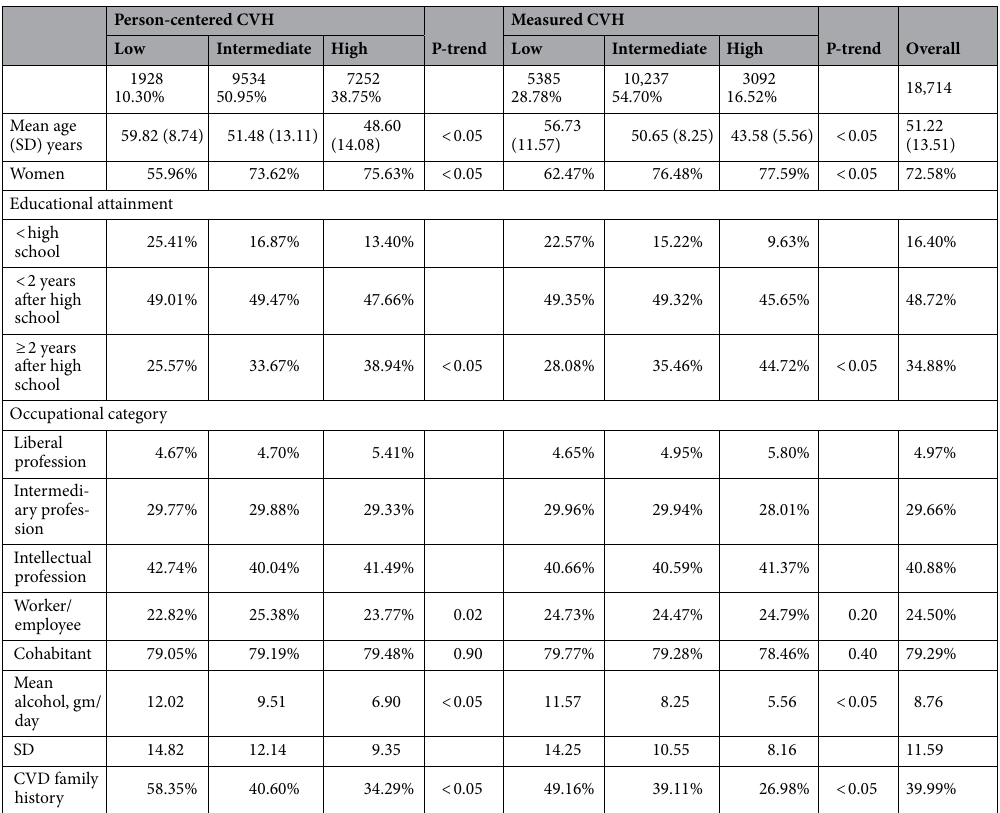
Table 2. Sample characteristics according to person-centered and measured CVH level. Values are percentages for categorical variables and mean (standard deviation) for numerical ones. Low, intermediate, and high CVH correspond to 0–2, 3–4, and 5–7 ideal LS7 metrics, respectively. Trend tests include Jonckheere trend test for numerical variables and the Chi-square trend test for categorical variables. Educational attainment categories were (1) low (less than high school), (2) intermediate (less than 2 years after high school), and (3) high (more than or equal to 2 years after high school). Occupational categories were (1) liberal professions (farmer, craftsperson, merchant, company director, specialized personnel, (2) intellectual professions, (3) intermediary professions, and (4) worker/